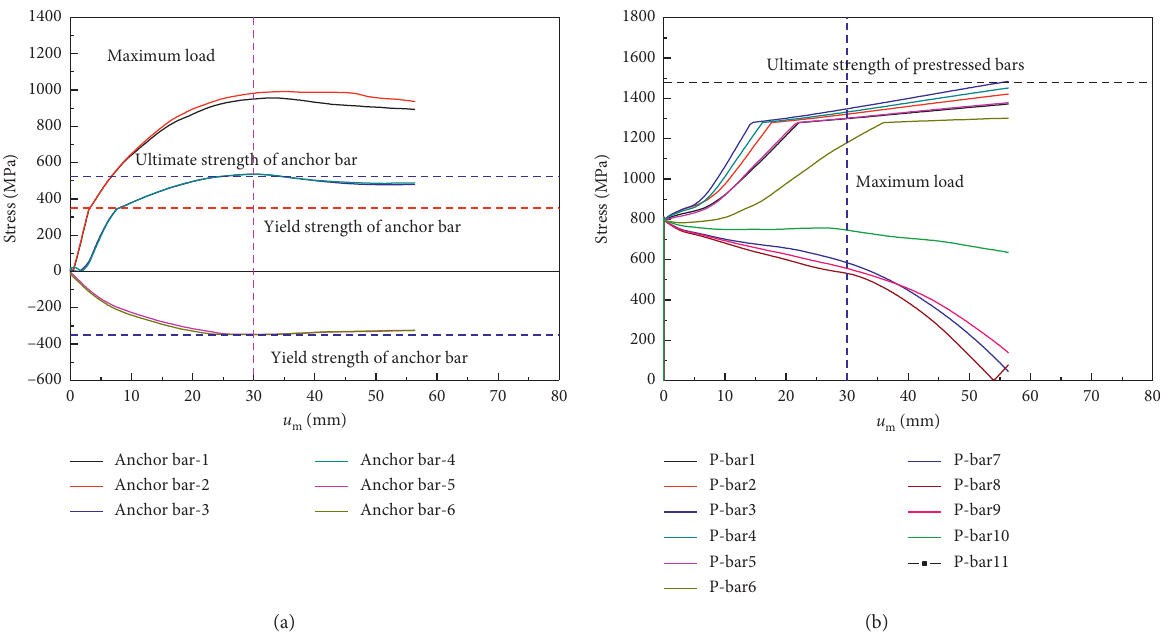
Figure 21: Stress-displacement curves of CT-7. (a) Anchor bar. (b) Prestressed